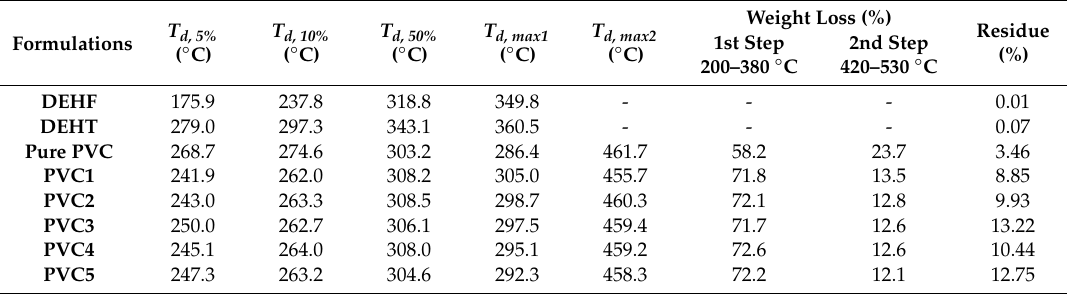
Table 3. Decomposition under N 2 atmosphere at 5%, 10%, and 50% weight loss ( T d,5% , T d,10% and T d,50% , respectively) and maximum decomposition ( T d,max ) temperatures of plasticized PVC films, and their pure components